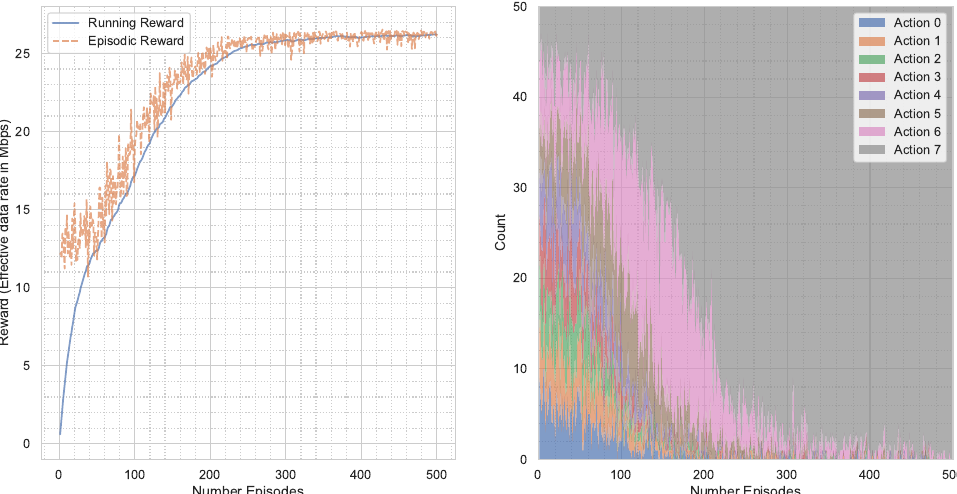
Figure 8. The behavior of the NAC reinforcement learning approach on a real-world channel at a static SNR level of